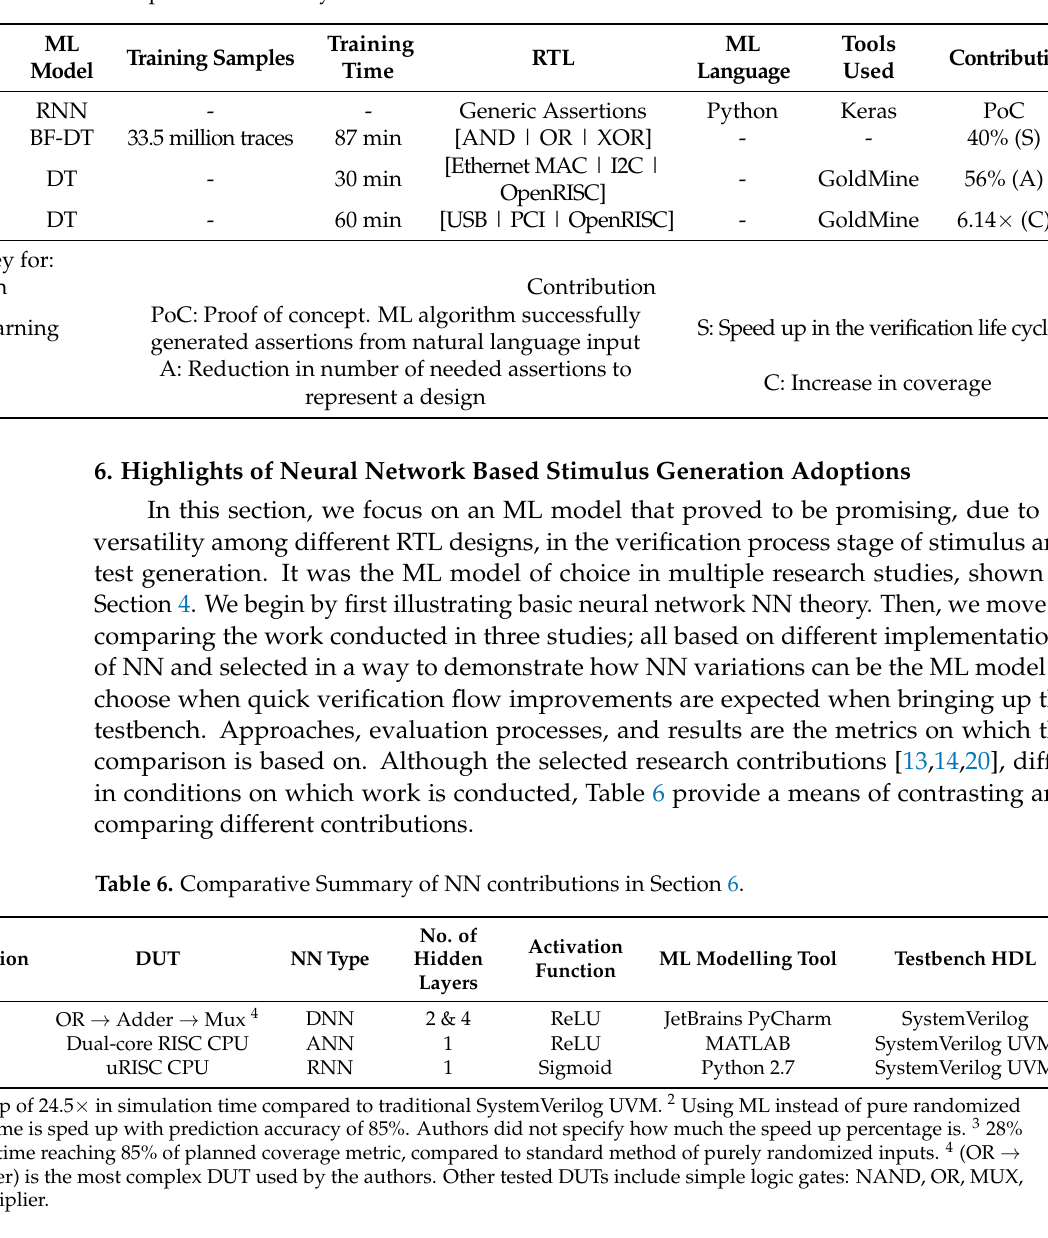
Table 5. Comparative summary of state of the art ML contributions in Section 5.5.